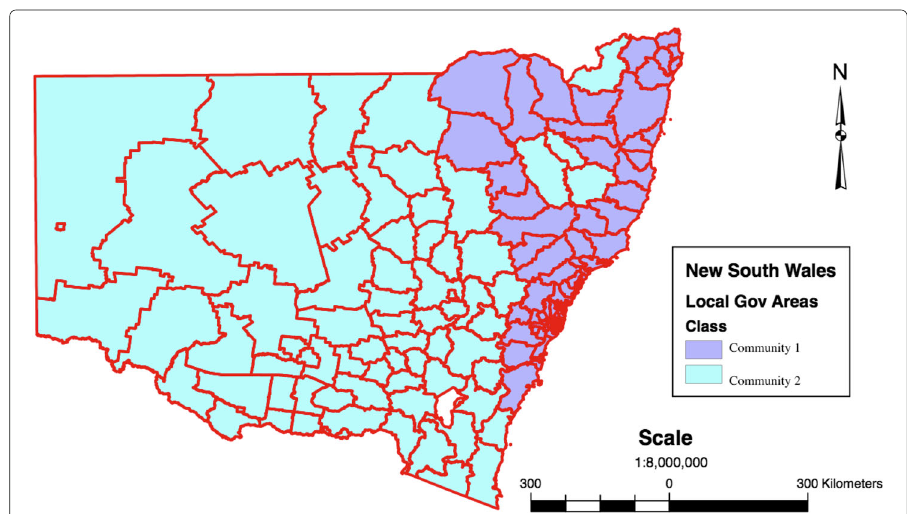
Fig. 6 Geographical divide of NSW communities found using Infomap (c.f. Alzahrani and Horadam (2014), Fig.1a). The uncoloured area is the Australian Capital Territory, which does not form part of NSW